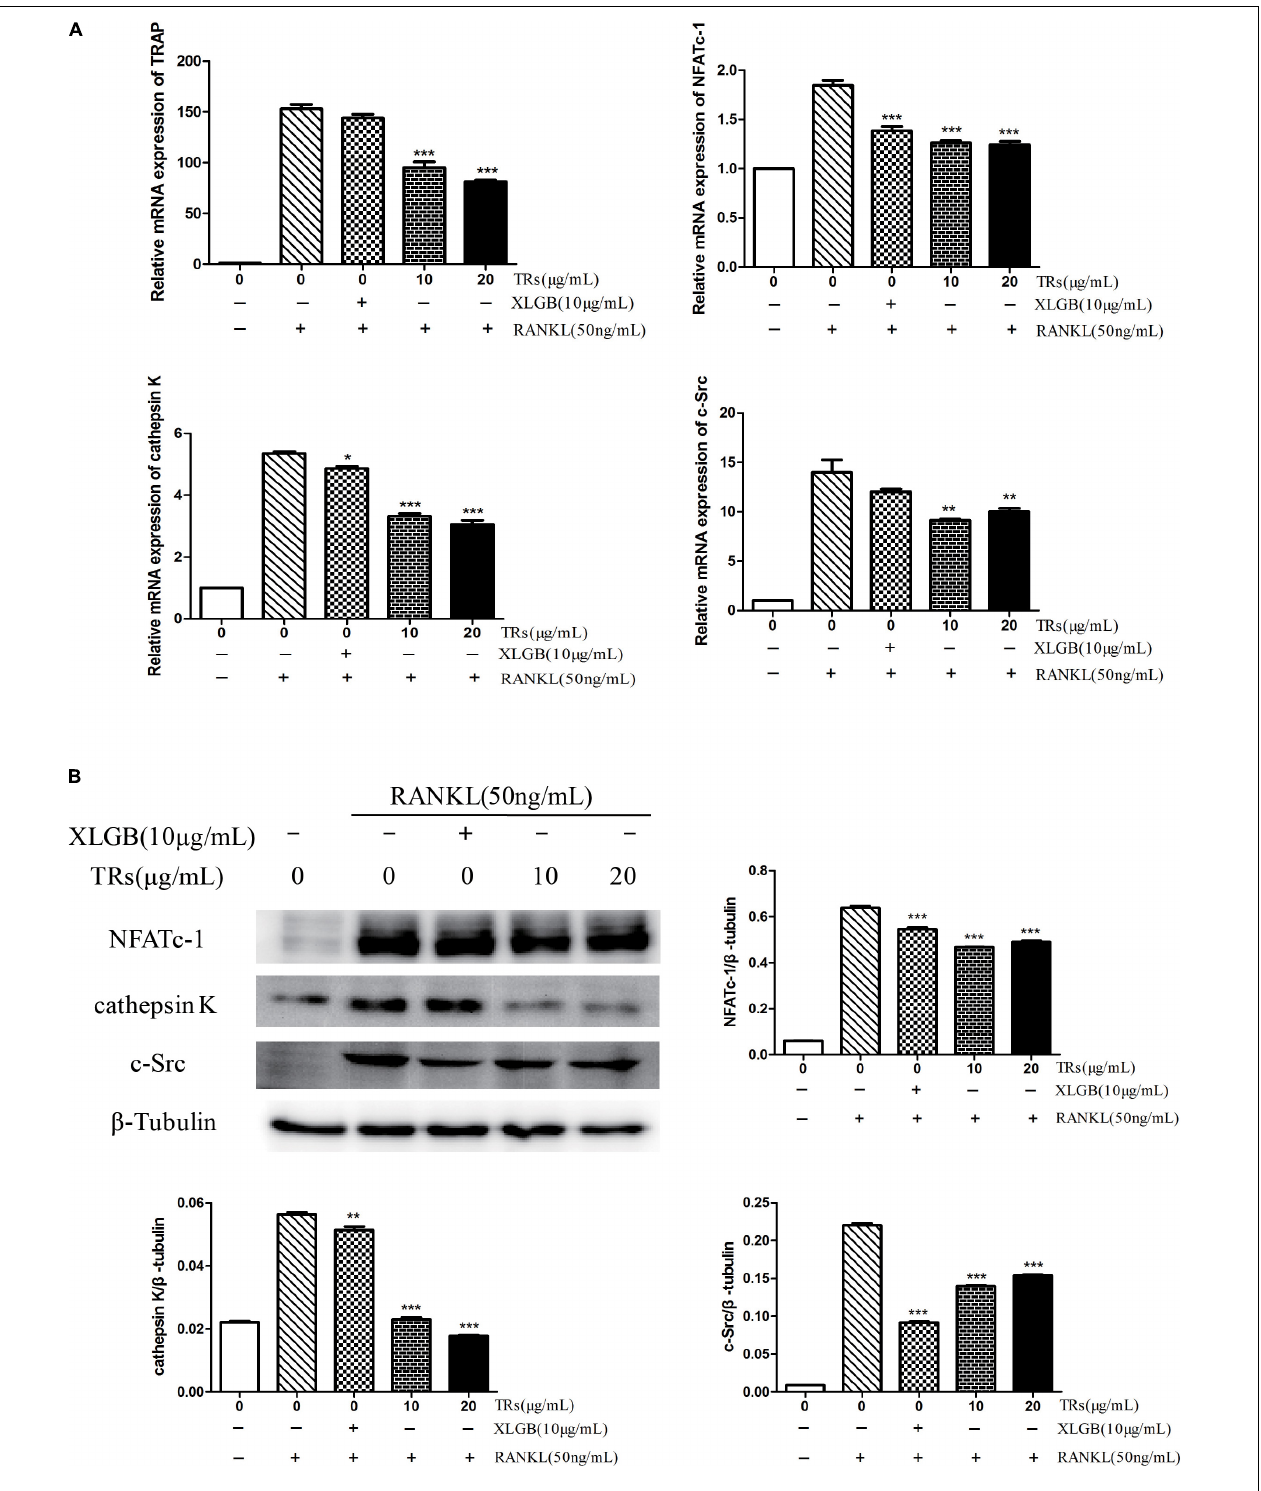
FIGURE 7 | The Effects of thearubigins (TRs) on the expression of genes and proteins related osteoclastogenesis. Thearubigins (TRs) reduce the levels of genes and proteins related to osteoclast formation. The levels of specific genes and proteins were determined by qRT-PCR and western blotting for osteoclasts treated with TRs. (A) The mRNA expression levels of TRAP, NFATc-1, cathepsin K, and c-Src. (B) The protein expression levels of NFATc-1, cathepsin K, and c-Src and the results were quantified using AlphaView software. All data are presented as the mean ± SEM ( n = 3). “One way ANOVA” was used for the comparison of BTE treatment vs only RANKL treatment. ∗ p < 0.05, ∗∗ p < 0.01, and ∗∗∗ p < 0.001 vs only RANKL treatment.